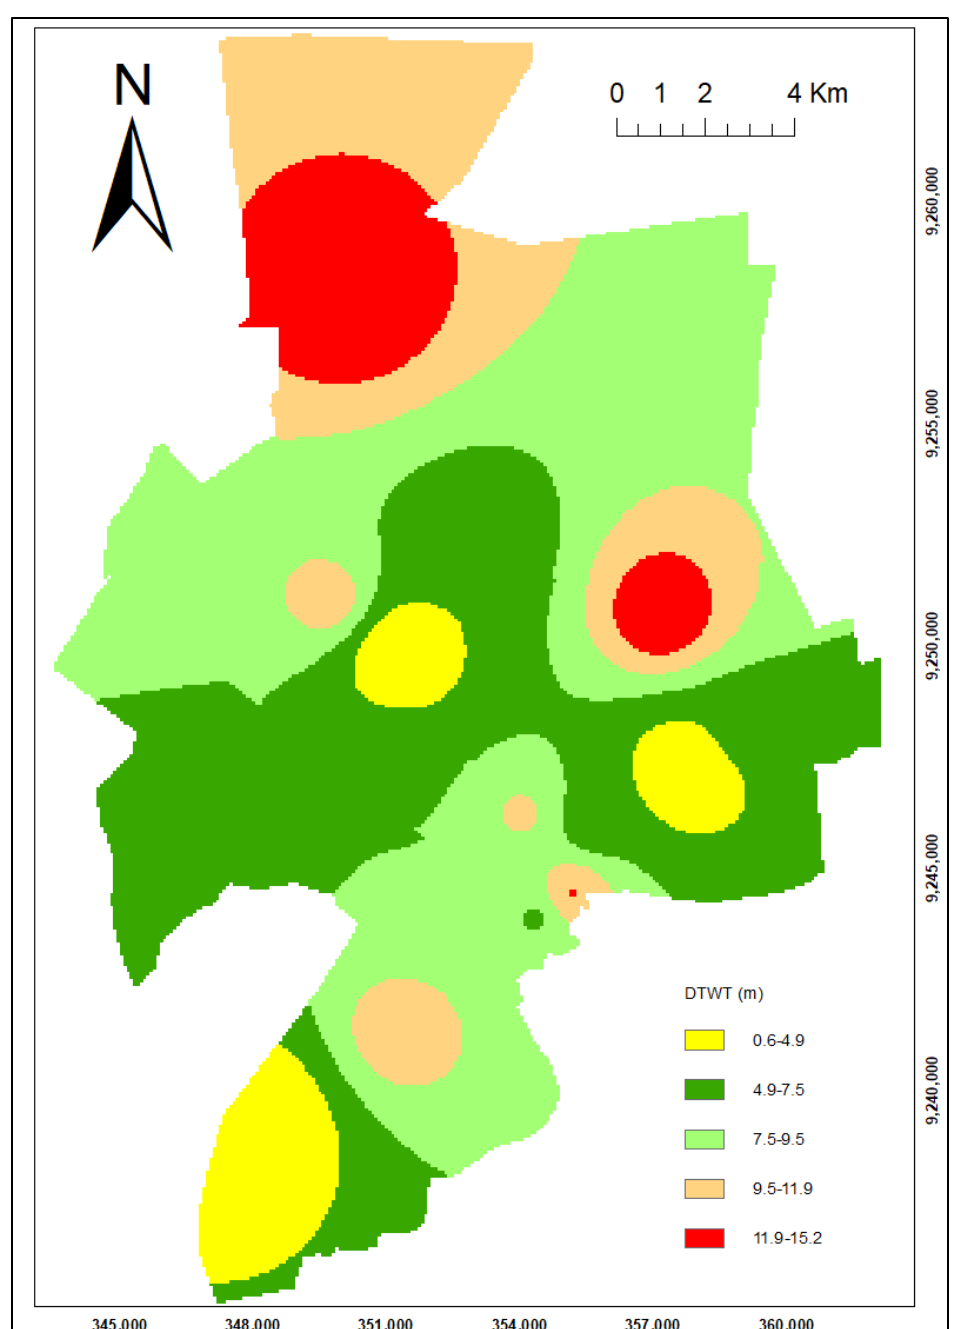
Figure 5. Depth to water table